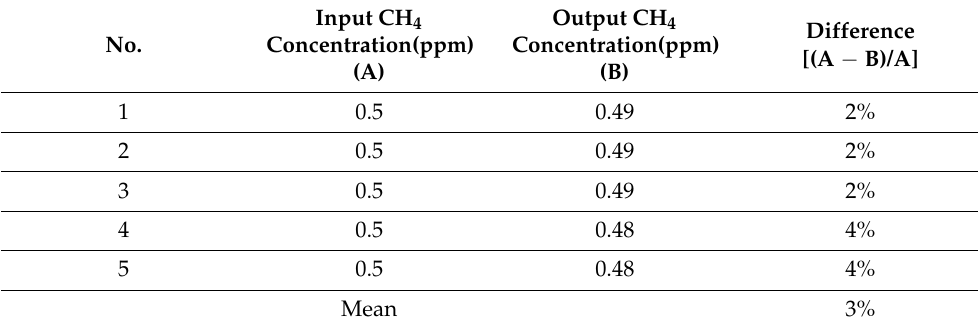
Figure 4. Component of continuous sampling equipment. Table 2. Verification test of flue gas sampling equipment.